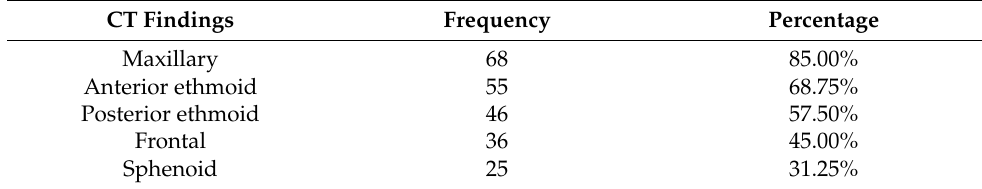
Figure 1. Distribution of Lund–MacKay scores of study subjects. Table 2. CT findings of study subjects.